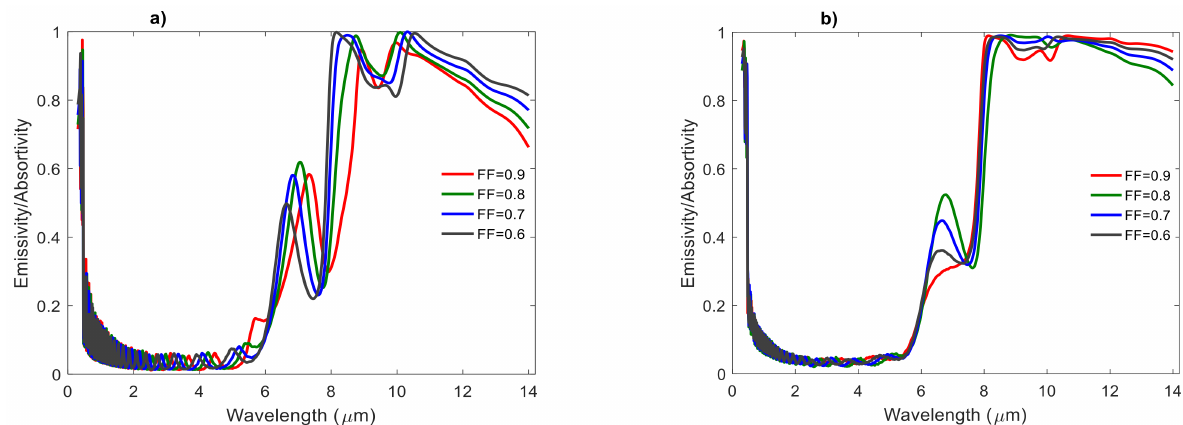
Figure 4. Effect of filling ratios for the selective emitter: Spectral averaged emissivity at filling ratios from 0.6 to 0.9 of TiO 2 -SiO 2 with a filling ratio (FF = 0.8) of Ni-Al 2 O 3 . ( a ) Left-hand side of column indicates a normal incidence and ( b ) right-hand side of column indicates an oblique incidence.